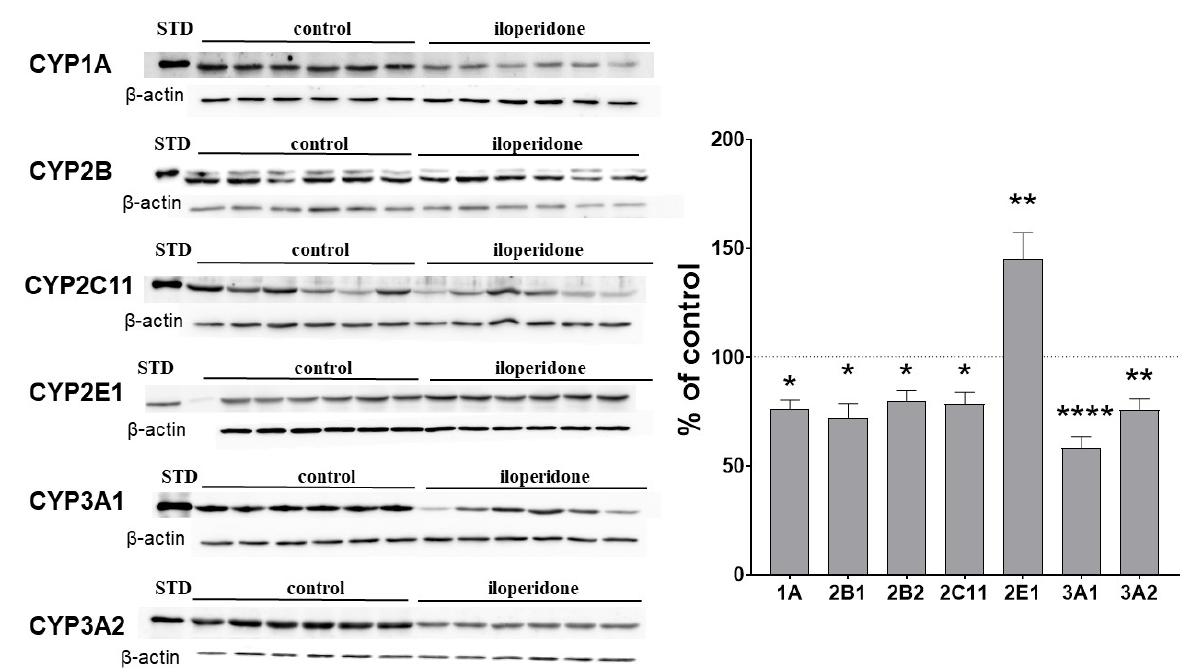
Figure 2. The effect of two-week treatment with iloperidone on the protein levels of CYP1A, CYP2B, CYP2C11, CYP3A, and CYP2E1 enzymes in rat liver microsomes. Microsomal proteins (10 μ g) were subjected to the Western immunoblot analysis. The results are presented as representative blots from six (for the control and for iloperidone treatment) separate rats per treatment. The data are expressed as the mean ± S.E.M. ( n = 12). Statistical significance was assessed by Student’s t-test and marked as * p < 0.05, ** p < 0.01, **** p < 0.0001, compared with the control.